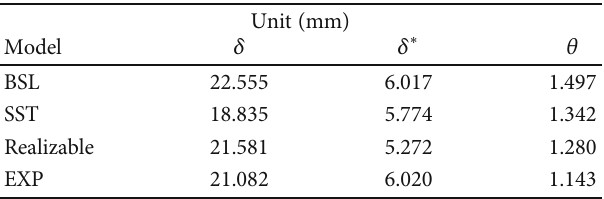
Figure 8: Mach number (a) and turbulent viscosity ratio (b) Table 8: Boundary layer thickness.